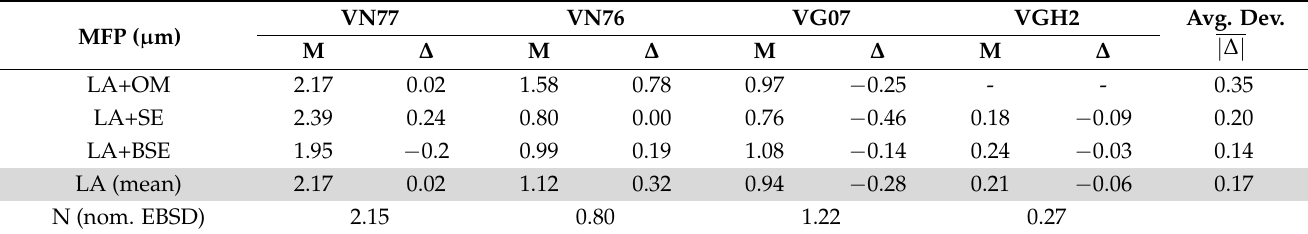
Table 11. Mean free path (MFP) obtained by the